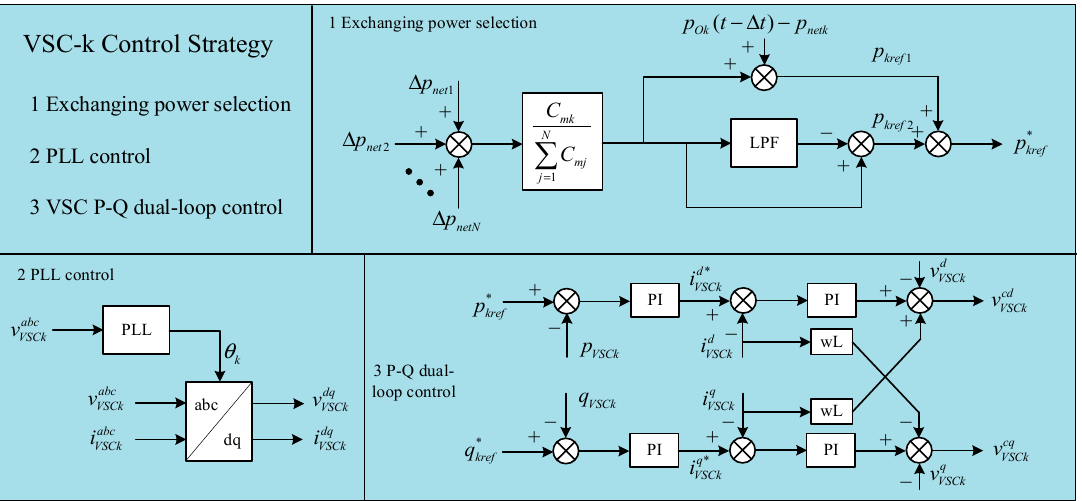
Figure 4. The control diagram of VSC-k.